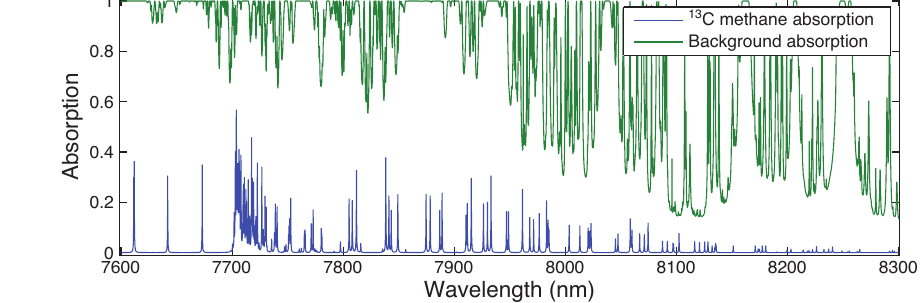
Figure 5 Simulated absorption spectrum from ORFM in the wavelength range 7600–8300 nm, the y scale represents the fraction of radiation absorbed by the molecules under investigation. The blue line represents absorption by 13 Ch 4 and green represents all other key absorbing background gases (CO , 2 h O, N O and 12 Ch 2 2 4